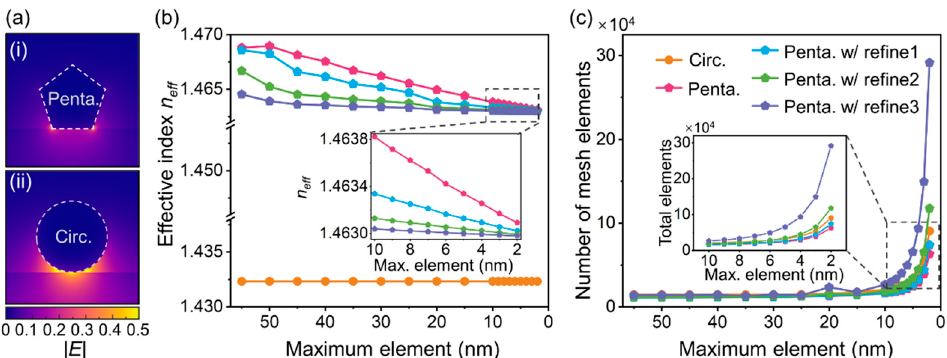
Figure 1. Emerging computational resource requirement for MNWs with abrupt geometric features and broken symmetries. ( a ) Mode profiles in terms of normalized electric field norm distributions in the typical ( i ) pentagonal MNW and ( ii ) circular MNW. For better visualization, they are plotted in a color bar ranging from 0 to 0.5 with saturation. ( b ) Calculated effective index n eff vs. maximum mesh element size. ( c ) Total number of mesh elements vs. maximum mesh element size of MNWs. Insets in ( b , c ): enlarged views for maximum mesh size ranging from 2–10 nm. Orange dotted line: circular MNW. Red, blue, green, and purple lines with pentagonal symbols: pentagonal MNWs with 0–3 times regional meshing refinements (see Figure S1 in the Supplementary Materials for details). The MNW was placed on a silica substrate with a diameter of 300 nm working at 880 nm wavelength.